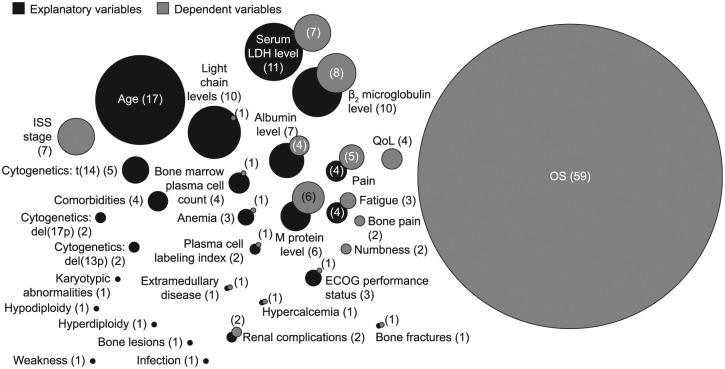
Explanatory and dependent variables identified from literature
reviews.ECOG, Eastern Cooperative Oncology Group; ISS, International Staging
System; LDH, lactate dehydrogenase; OS, overall survival; QoL, quality
of life.From the attributes identified, 26 were deemed explanatory variables and
20 were dependent variables. Numbers in brackets are the number of times
that the model attribute was featured in the findings of the literature
search. Overlap of circles means that an attribute was found to be both
a dependent and explanatory attribute.Explanatory variables: age,46–48,60,61,63–71,74,77,80 serum LDH
level,46,51,62,64,65,73,76,79–81,88 light chains level,44,46–54 β2
microglobulin level,51,62,64,70,71,79–81,89,90 albumin
level,53,64–66,71,79,80 M protein level,59,70,91–93 t(14),55–59
pain,69,83,85,87 bone marrow plasma cell count,64,71,80,94
comorbidities,45,63,76,78 fatigue,69,82,83,87
ECOG performance status,46,71,75 anemia,51,65,72
del(13p),55,57
del(17p),55,57 plasma cell
labeling index,58,95 renal complications,72,76 hypodiploidy,55 hyperdiploidy,96 karyotypic abnormalities,59 extramedullary disease,45 hypercalcemia,65 bone lesions,84 weakness,83 bone fractures,69 and infection.69Dependent variables: OS,45–47,49–51,54–61,63–65,67,68,71–74,76,78–81,87–90,96–122 β2
microglobulin,55,73,106,109,123–126 serum LDH
level,62,88,112,117,120,123,126 ISS stage (albumin, β2
microglobulin),55,70,109,117,123,126,127 M protein
level,59,90,92,124,128 pain,75,86,129–131 albumin
level,55,109,117,123 QoL,69,75,82,83 fatigue,85,129,130
numbness,130,131 renal
complications,53,65 bone
pain,129,130 bone fractures,132 hypercalcemia,133 extramedullary disease,102 ECOG performance status,75 anemia,93 light chains level,118 plasma cell labeling index,95 and bone marrow plasma cell count.124